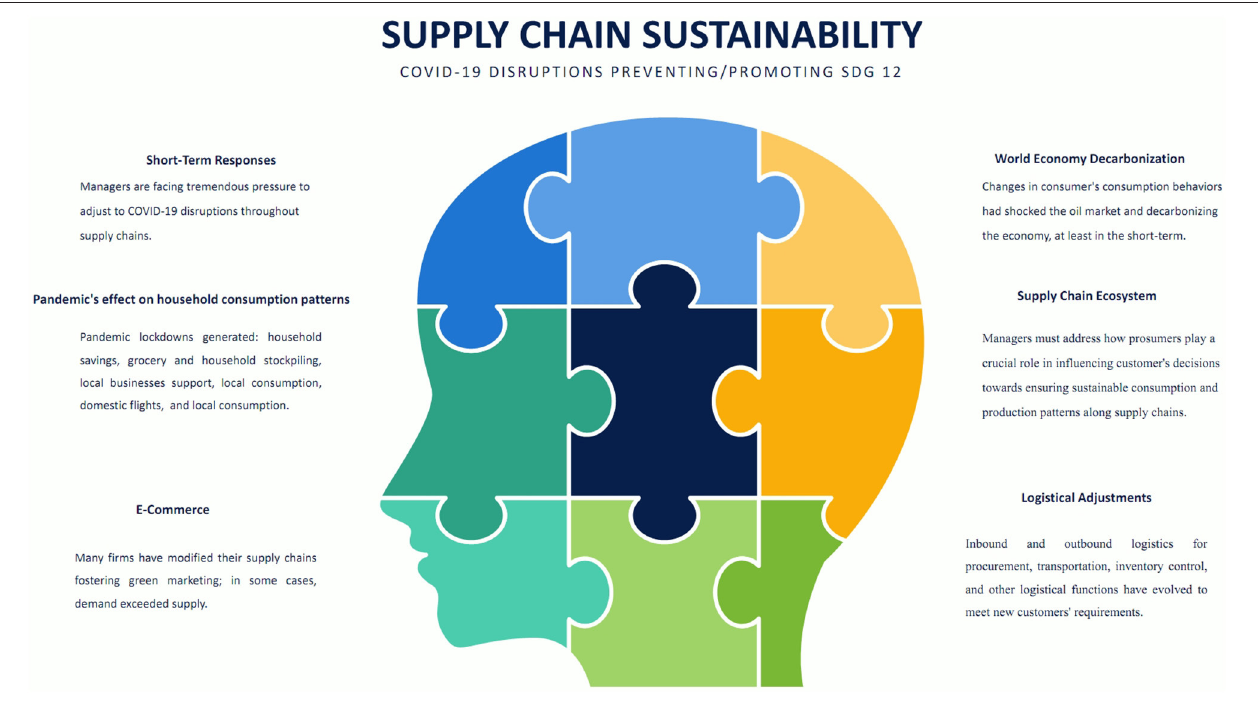
FIGURE 1 | COVID-19 disruptions preventing or promoting the SDG